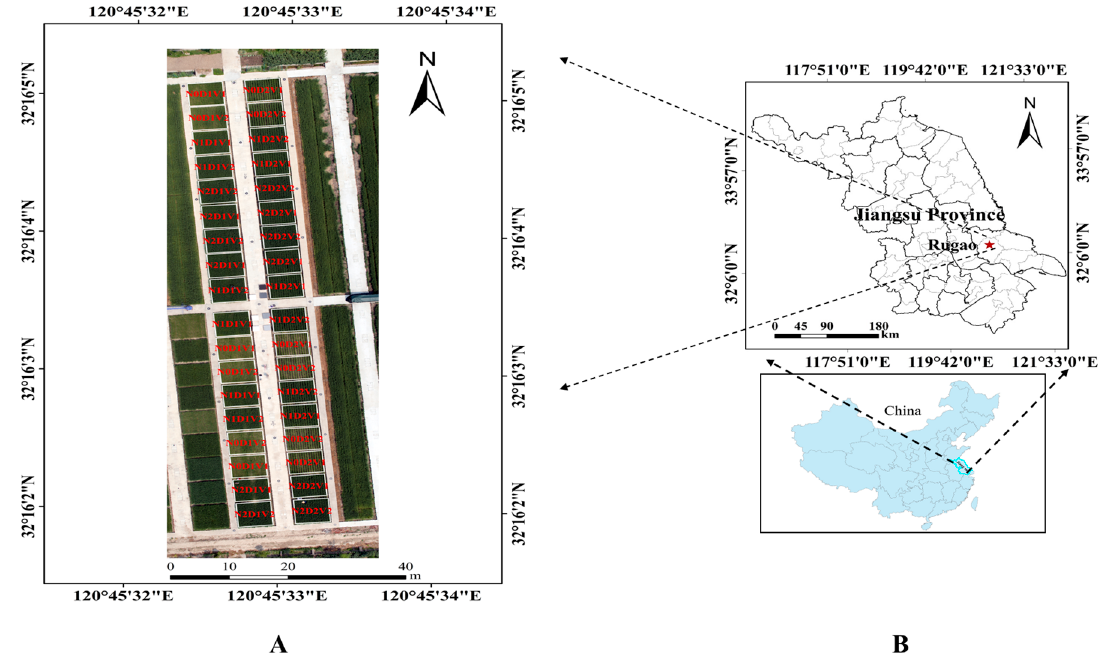
Figure 1. The UAV imagery with two winter wheat varieties (V1, V2), two densities (D1, D2), three nitrogen rates (N0, N1, N2) ( A ), location of our field pilot trial with 36 plots ( B ).